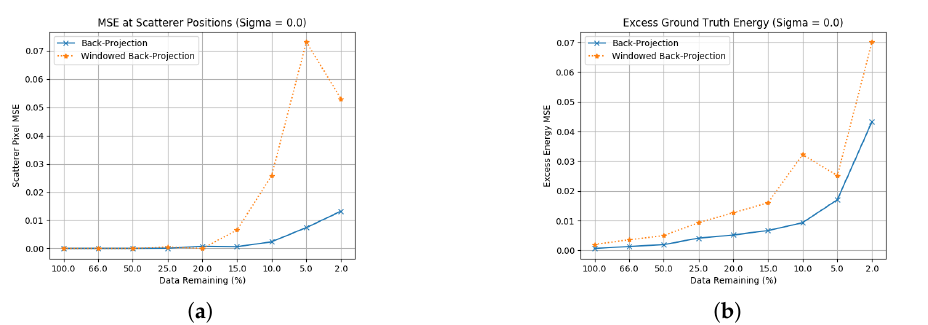
Figure 3. Ground truth estimation statistics for traditional SAR methods. ( a ) Scatterer location RCS error without noise; ( b ) Excess energy without noise.